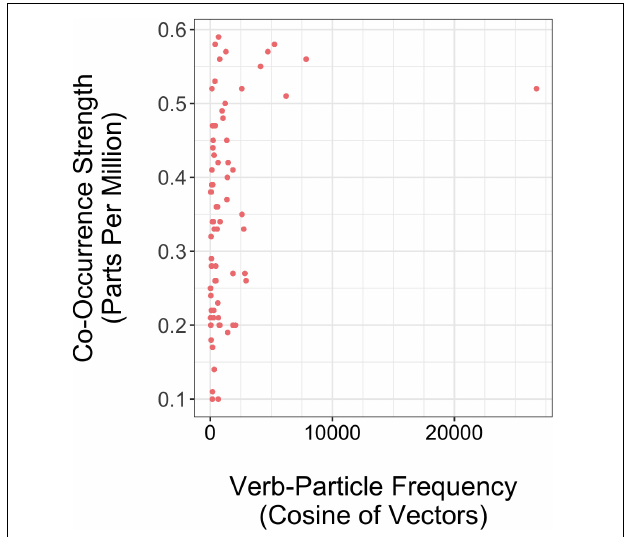
FIGURE 1 | Scatterplot depicting raw values for Co-Occurrence Strength and Verb-Particle Frequency for 78